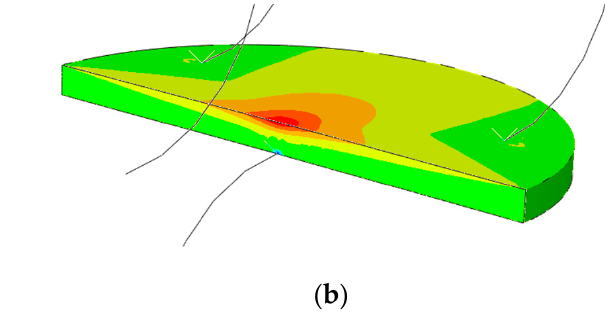
Figure 11. Ball-on-three-balls test: ( a ) test geometry for cylindric plates with and without top layer; ( b ) maximal principal stress for cut view of loaded cylinder.